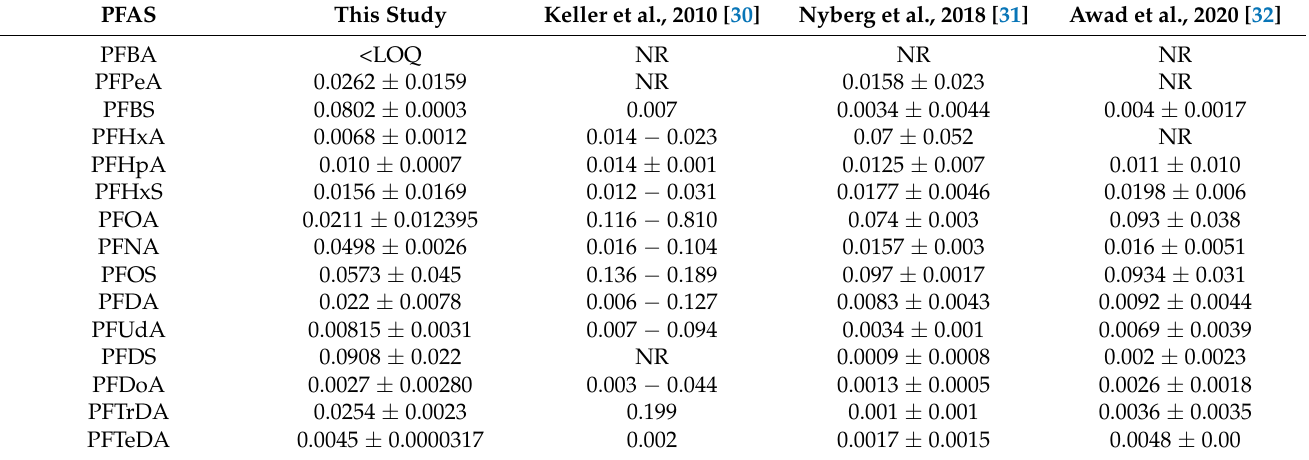
Table 3. Comparison of mean PFAS concentration (ng mL − 1 ± SD) in NIST SRM 1954 measured in this study with those concentrations reported by other